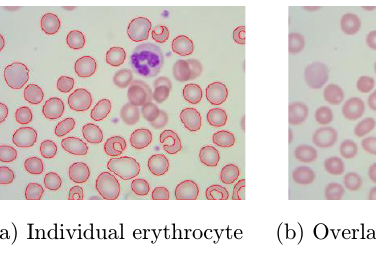
Fig. 3. Classi¯cation of erythrocytes.